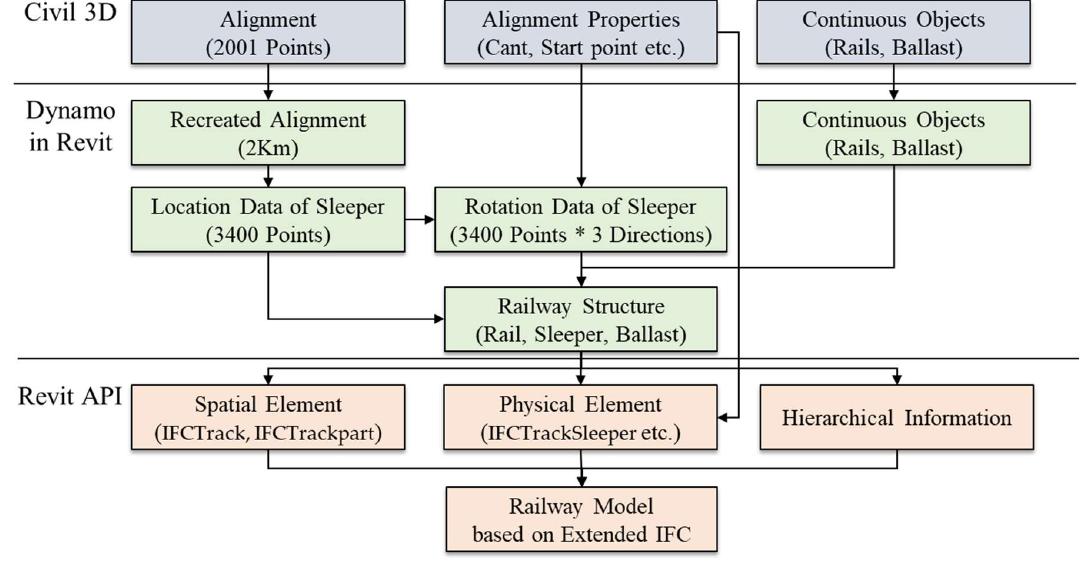
Figure 8. Process for followed for case study conducted at the: Railway in Osong-gun, located in South Korea.